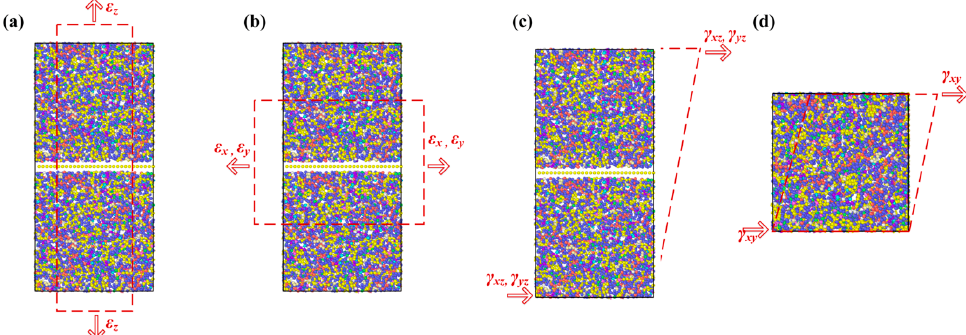
Figure 2. Deformation of Gr / epoxy nanocomposite: ( a ) longitudinal tension, ( b ) transverse tension, ( c ) longitudinal shear and ( d ) in-plane shear.